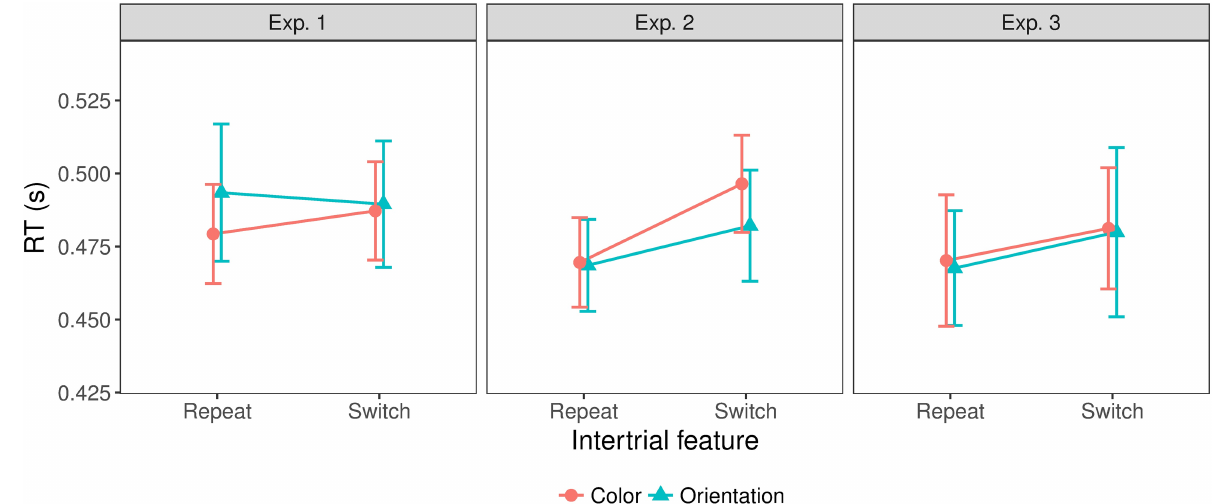
Fig 6. Feature repetition/switch effects on mean RTs for all three experiments. Error bars show the standard error of the mean.